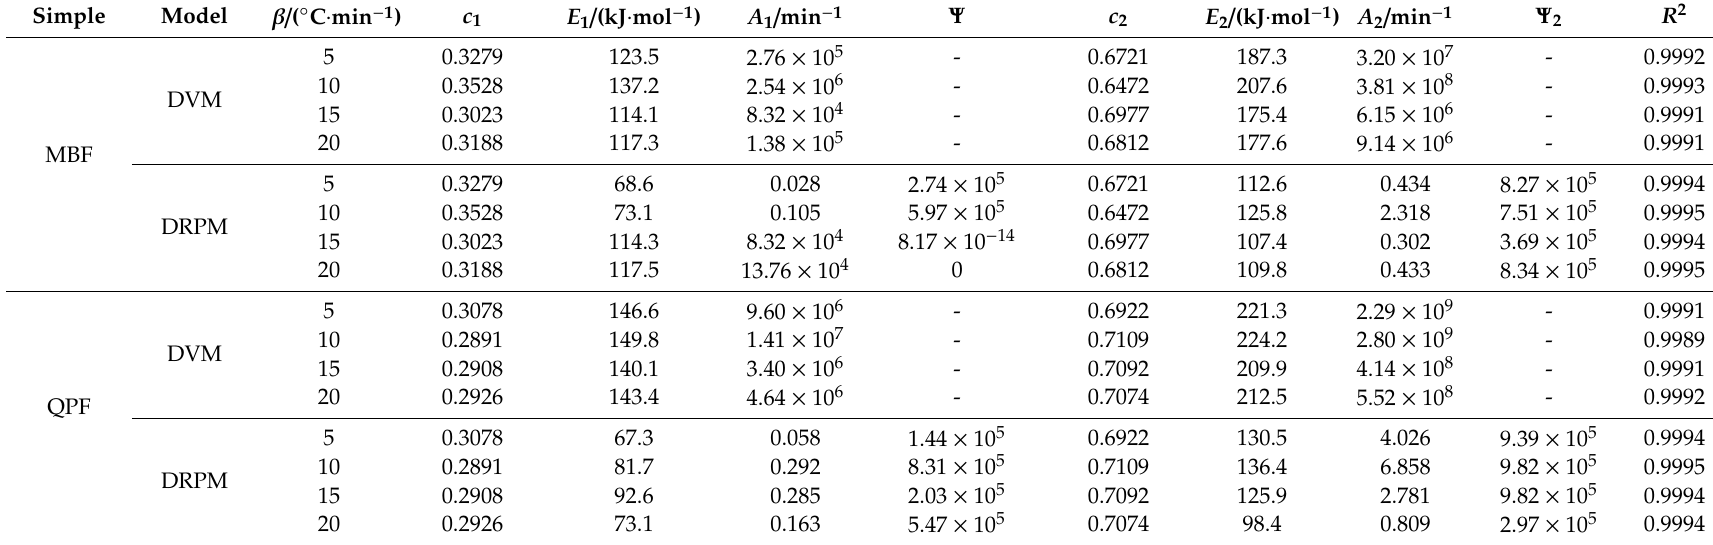
Table 6. Kinetic parameters of samples calculated from di ff erent